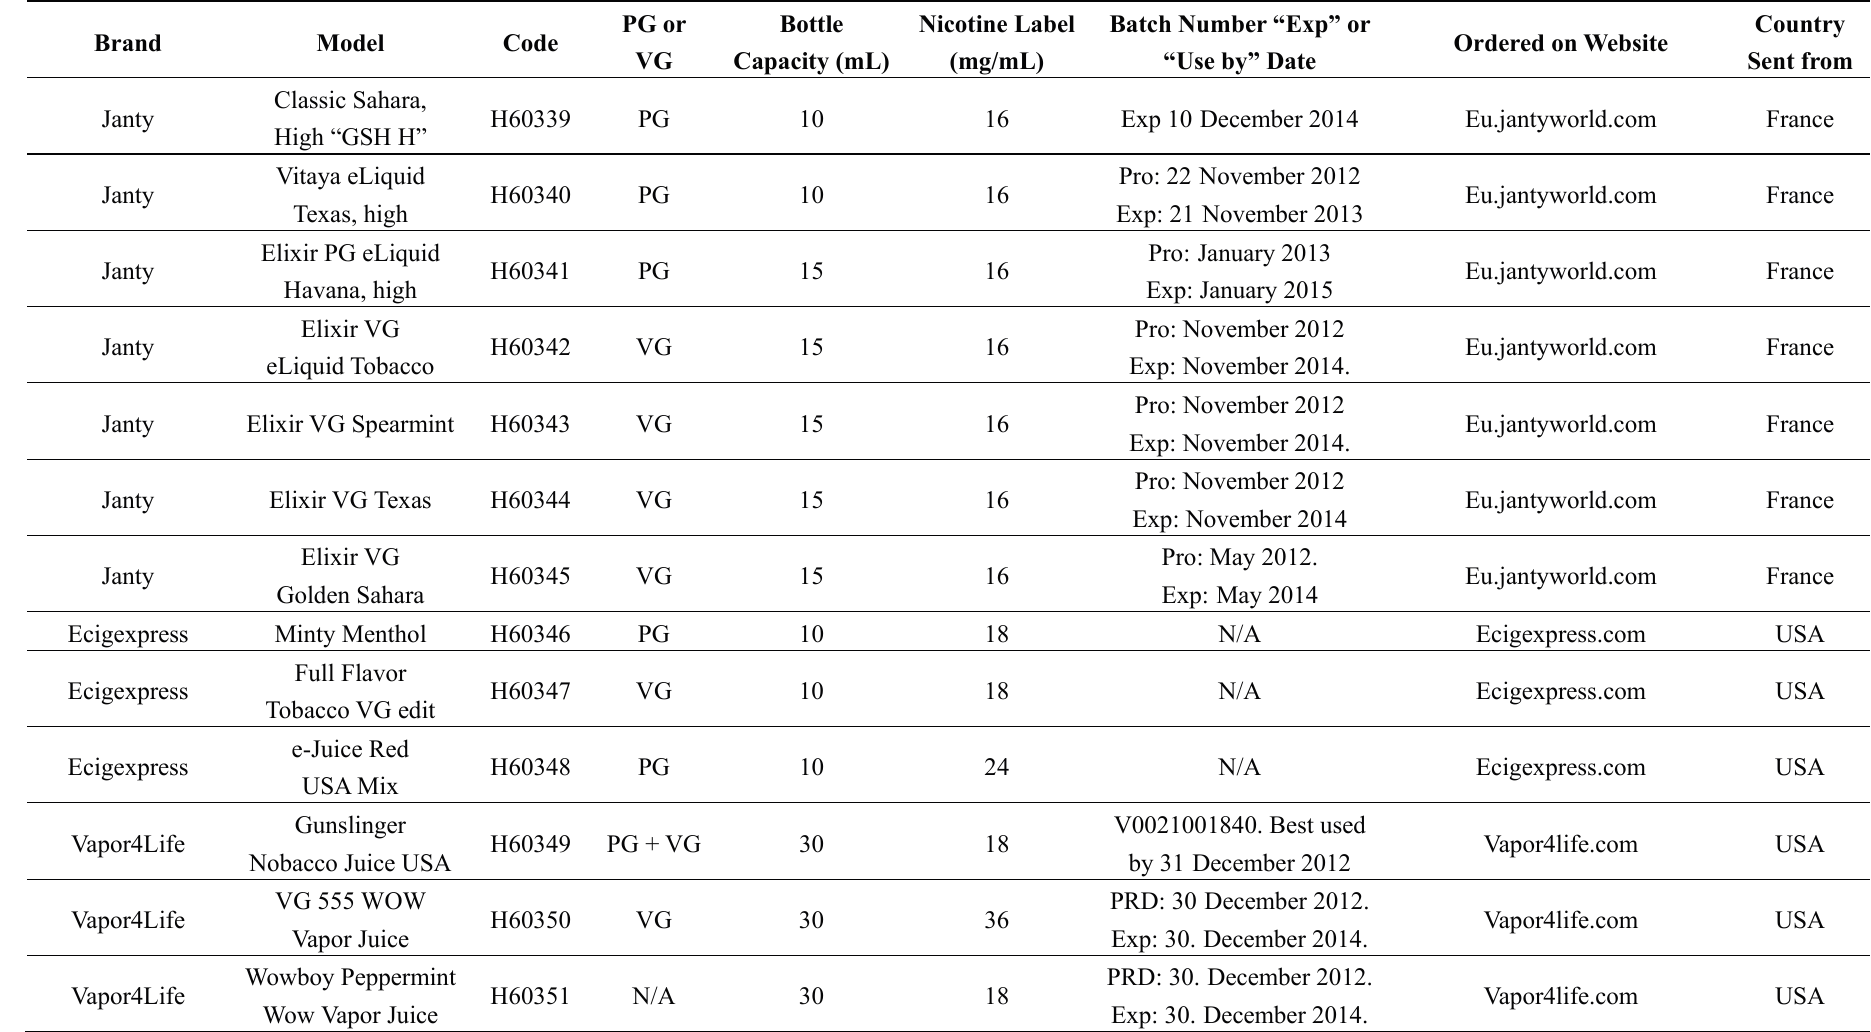
Table 1. Characteristics of 42 bottles of liquids for e-cigarettes,